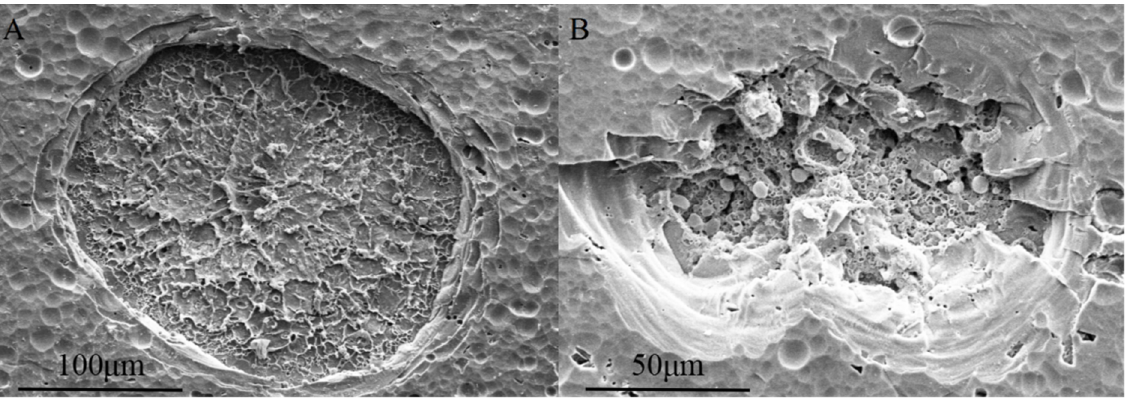
Figure 11. Typical morphology of laser damage pits on anodized films, ( A ) is complete peeling and ( B ) is gradient peeling. ( B ) is gradient